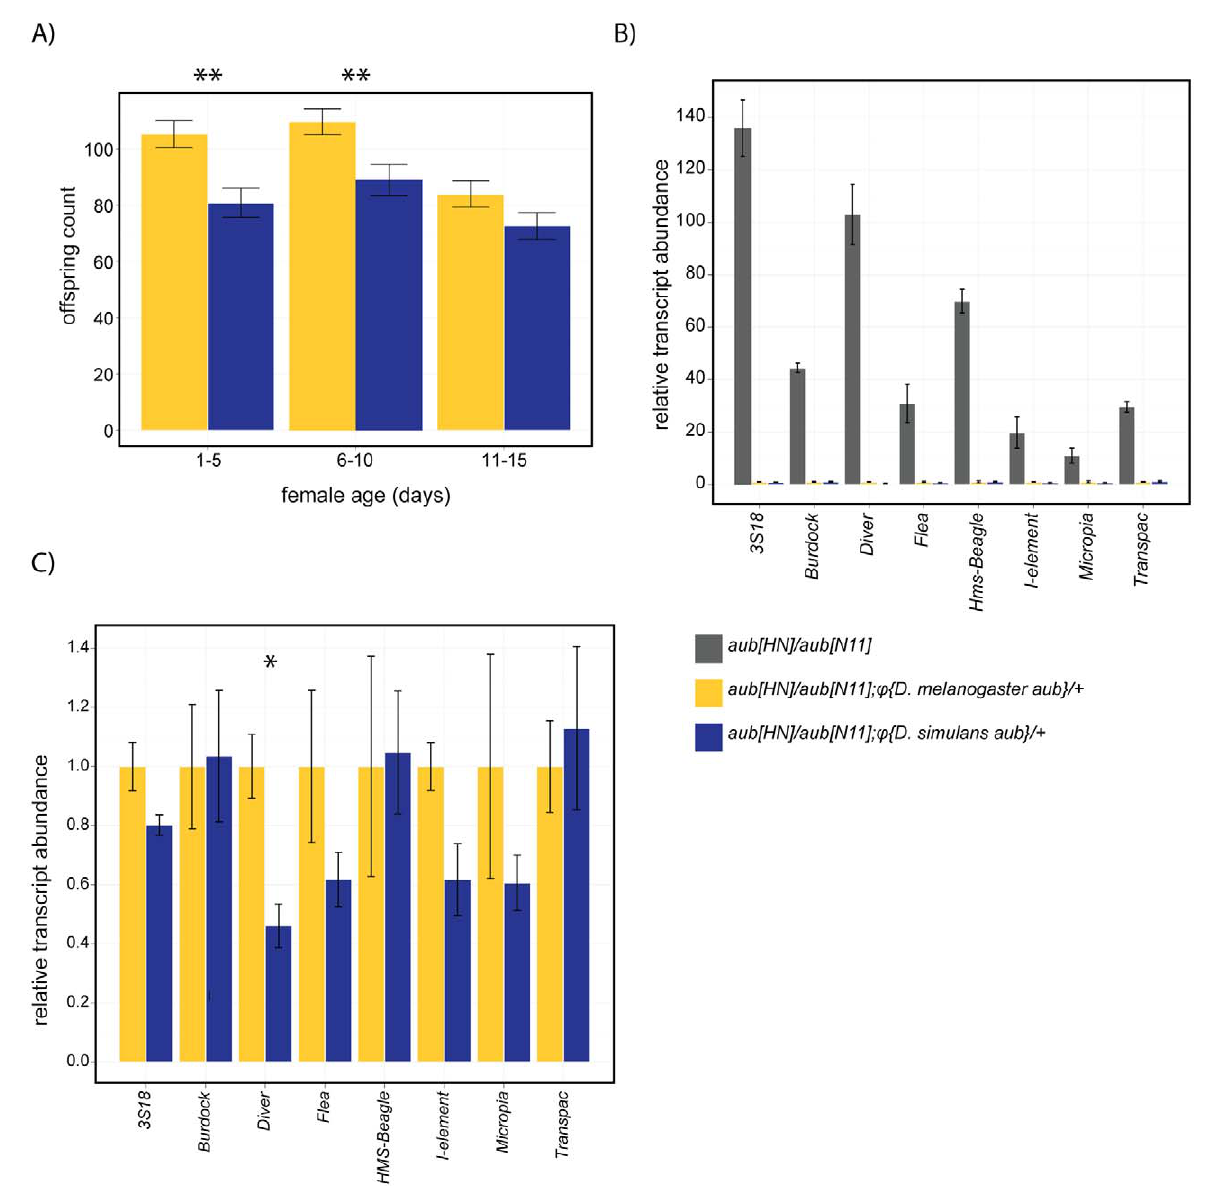
Figure 7. D.simulansaubergine does not fully complement a D.melanogasteraubergine mutant. w C31-mediated integrations of D. simulans aubergine and D. melanogaster aubergine transgenes are compared for their ability to complement aub HN /aub N11 for (A) female sterility across three different age ranges and for TE transcript abundance (B and C). Panel C contains the same data from the transgenic genotypes as in (B), replotted on a larger scale to illustrate potential differences between them. TE transcript abundance was determined relative to rpl32 and is scaled to the transcript abundance in aub HN /aub N11 ; w {D. melanogaster aubergine}/ + .